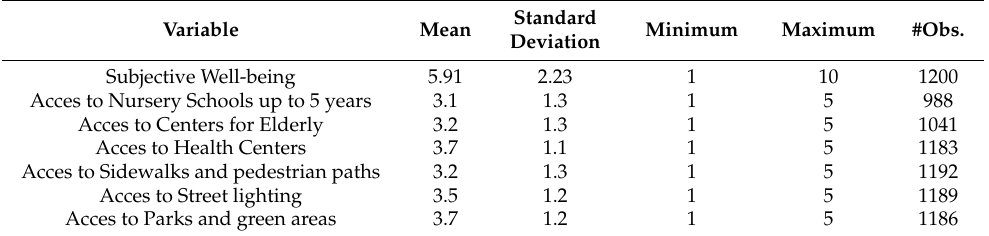
Table 4. Statistical summary of the variables Subjective Well-being and Access to the infrastructures. Variable